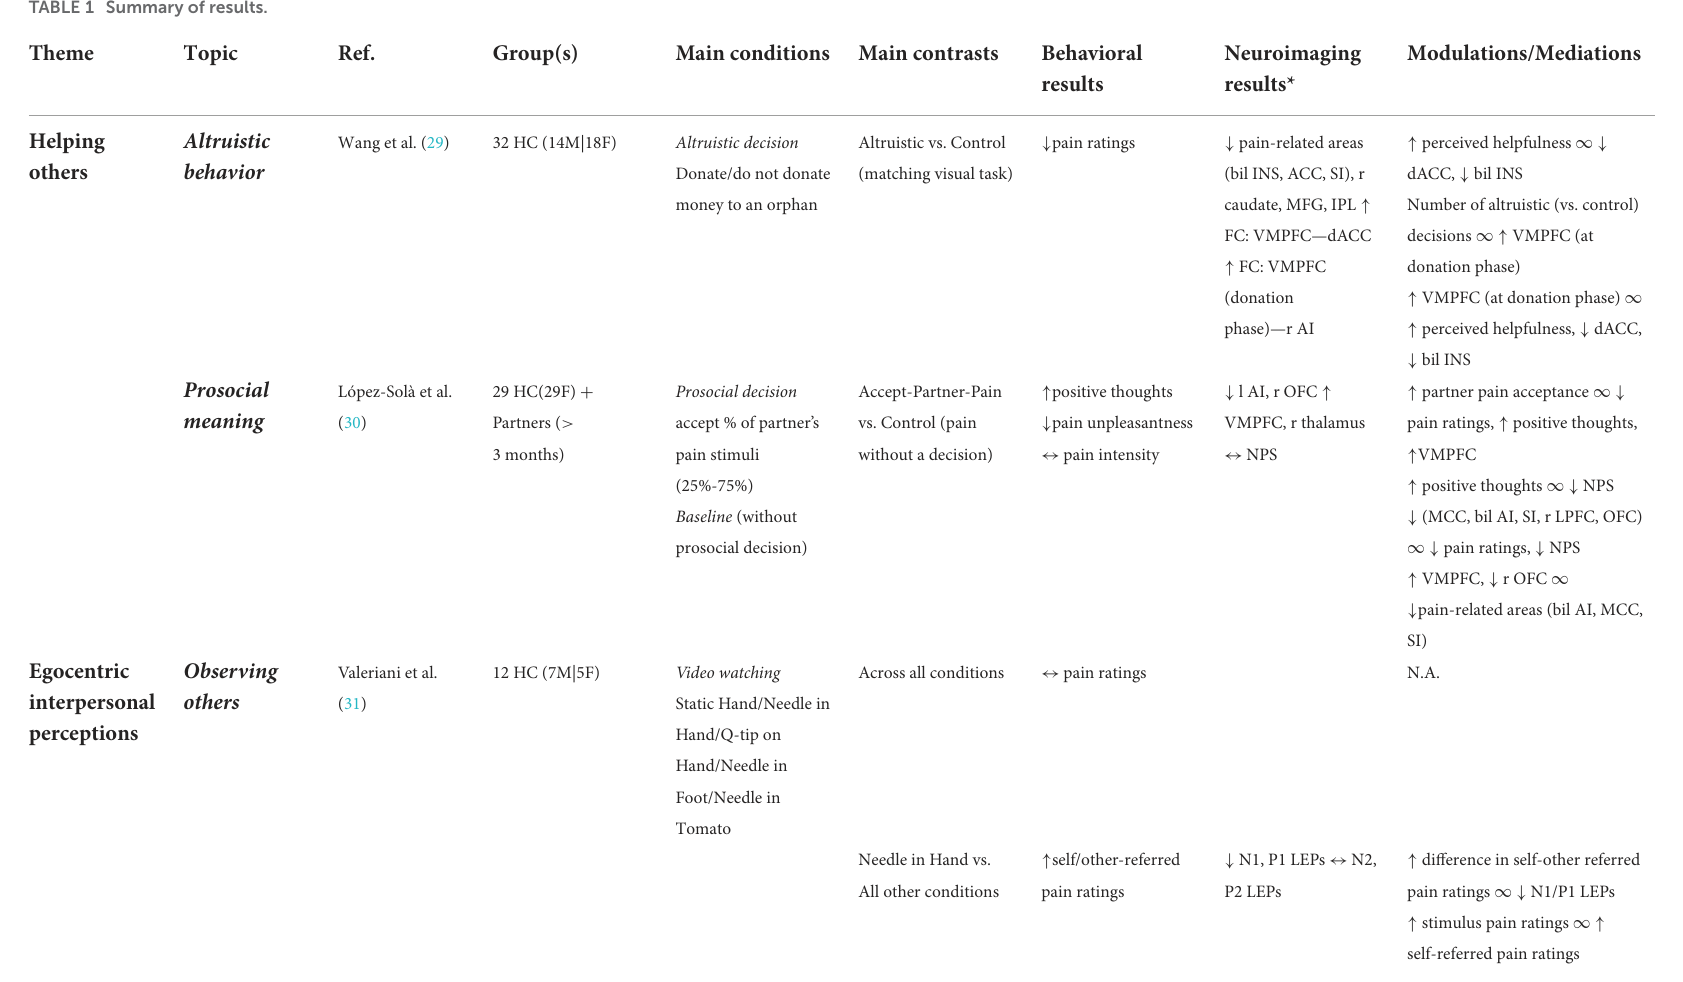
TABLE 1 Summary of